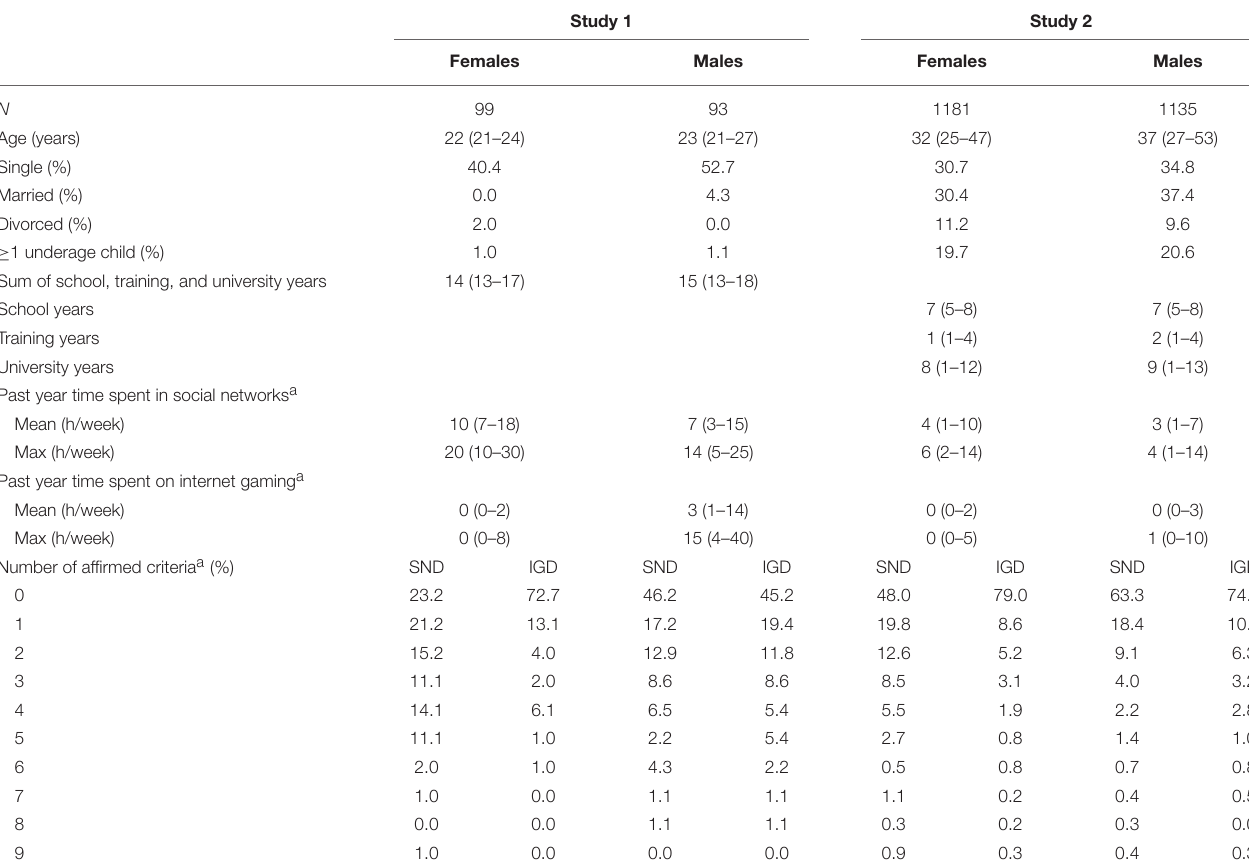
TABLE 1 | Sociodemographic characteristics.